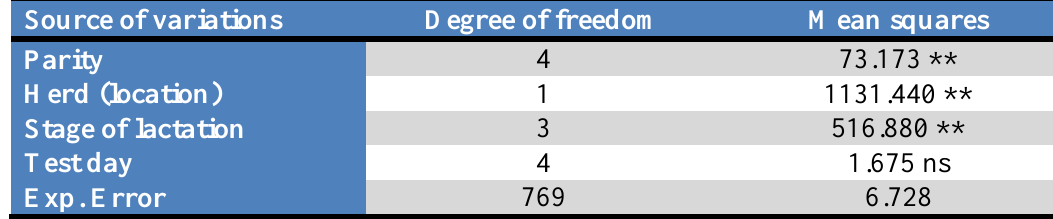
Table3. Analysis of variance for affecting factors in daily buffaloes milk yield Source of